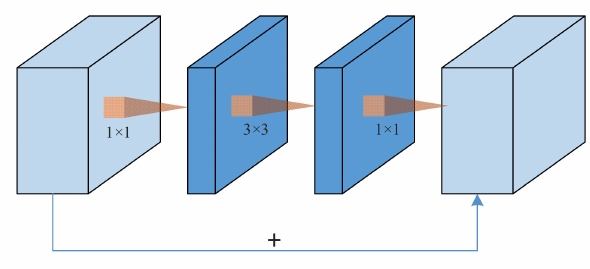
Figure 3. ResNet residual unit.